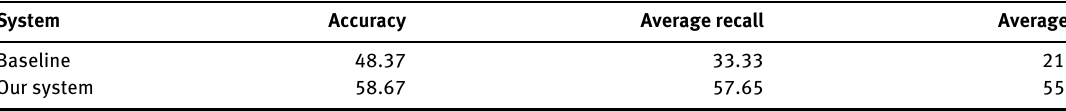
Table 4: Ten-fold Cross-Validation Result on Training